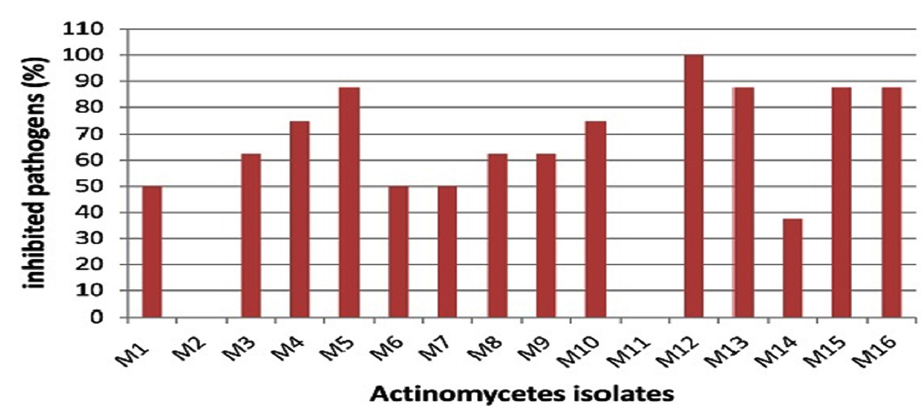
Fig. 1. Percentage of inhibited pathogens by different actinomycetes isolates